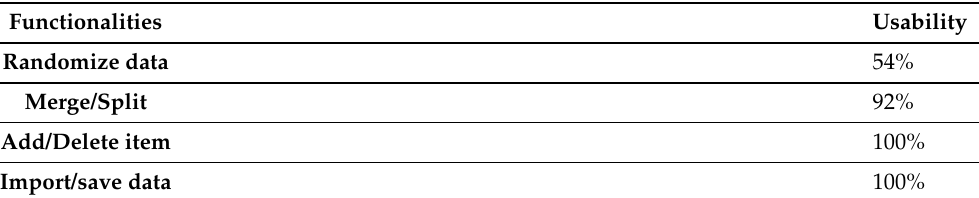
Table 3. User evaluations of CircleVis